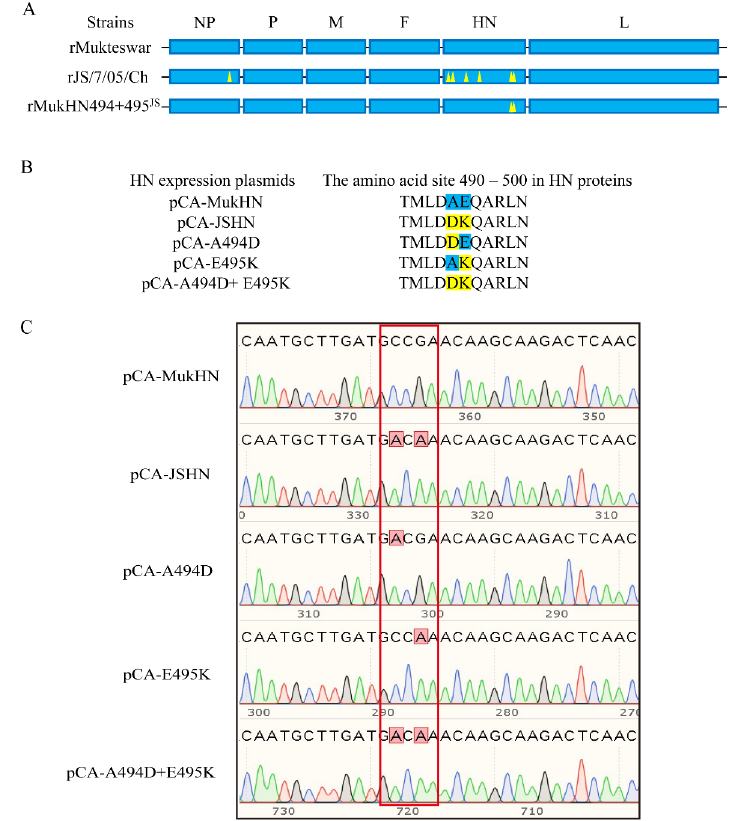
Figure 1. Schematic representation of the mutants used in this study. ( A ) Three NDV strains were used as model viruses in this study, including the vaccine strain rMukteswar, the vaccine variant strain rJS/7/05/Ch, and the dual-site mutant strain rMukHN494 + 495 JS . rMukHN494 + 495 JS was the rMukteswar derivative bearing the 494 and 495 aa of rJS/7/05/Ch. The aa mutations in the HN protein of NDV are marked with yellow triangles, including P438S in NP, and N19S, S29T, M145T, V266I, A494D, and E495K in HN. ( B ) Schematic representation of the aa mutations ranging from position 490 to 500 of different HN expression plasmids. Residues in blue and yellow indicate amino acids from Mukteswar and JS/7/05/Ch, respectively. ( C ) Constructed clones were identified by Sanger sequencing. The sequences of key mutation sites were displayed in red frames using the SnapGene 3.2.1 software. Table 1. Primer sequences used to amplify the HN and F sequences of the NDV genome.